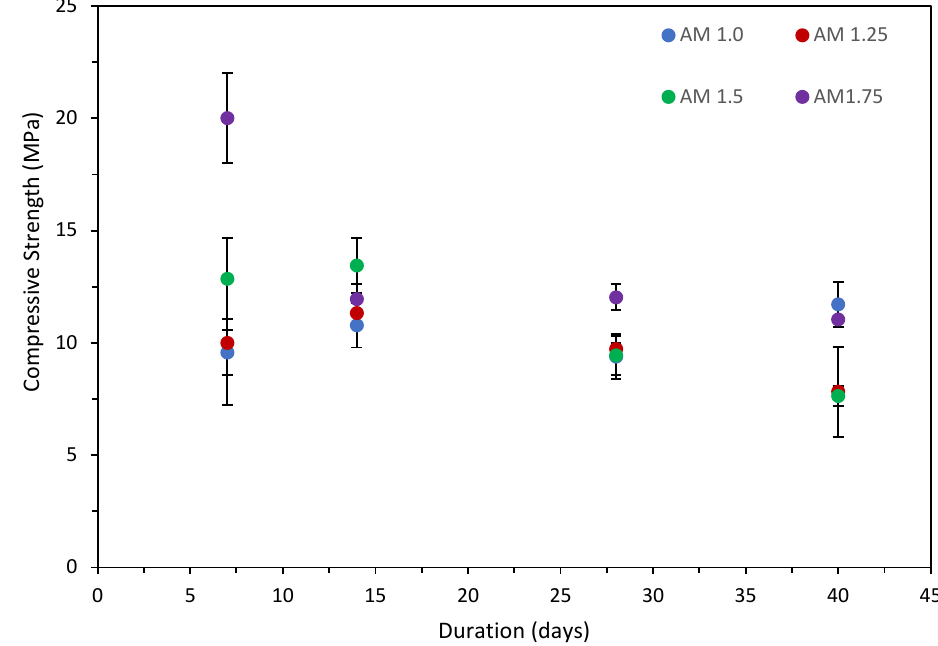
Figure 1. Compressive strength vs. time, 10% Na 2 O dosage specimens.